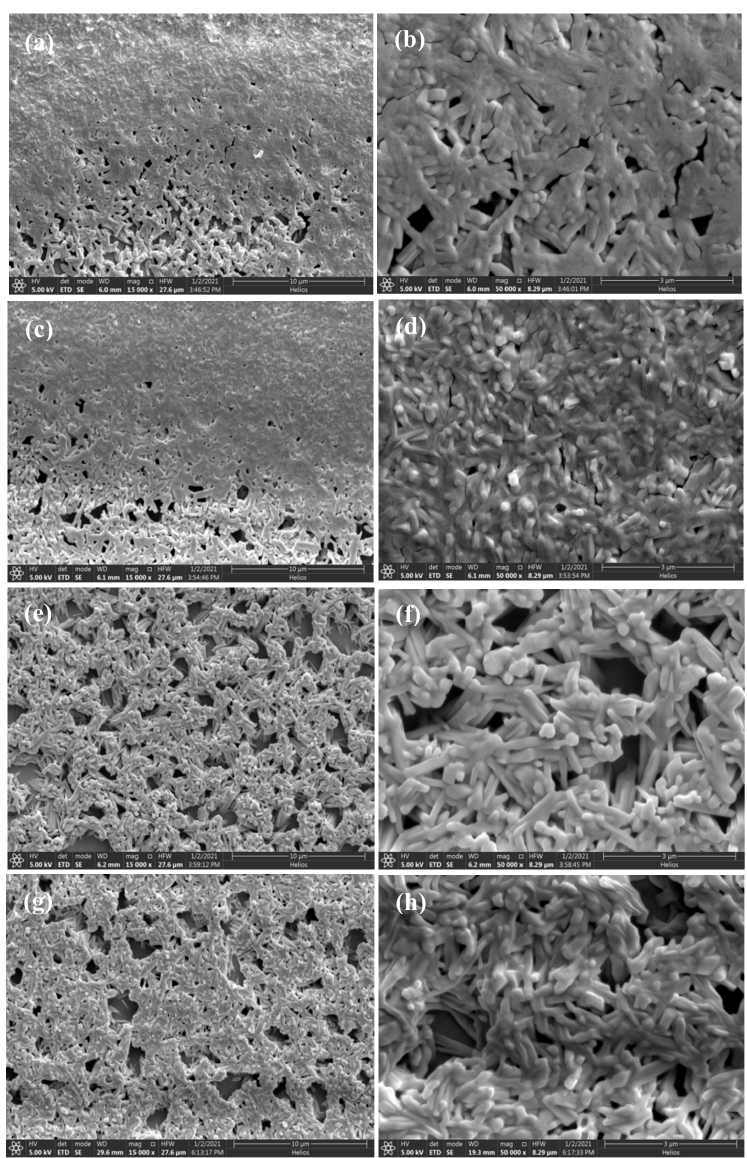
Figure 2. Different magnifications SEM top view of organic – inorganic hybrid ferroelectric thin films formed by different chlorobenzene dropping time. ( a , b ) 0 s in the second stage, ( c , d ) 5 s in the second stage, ( e , f ) 10 s in the second stage, and ( g , h ) 15 s in the second stage.